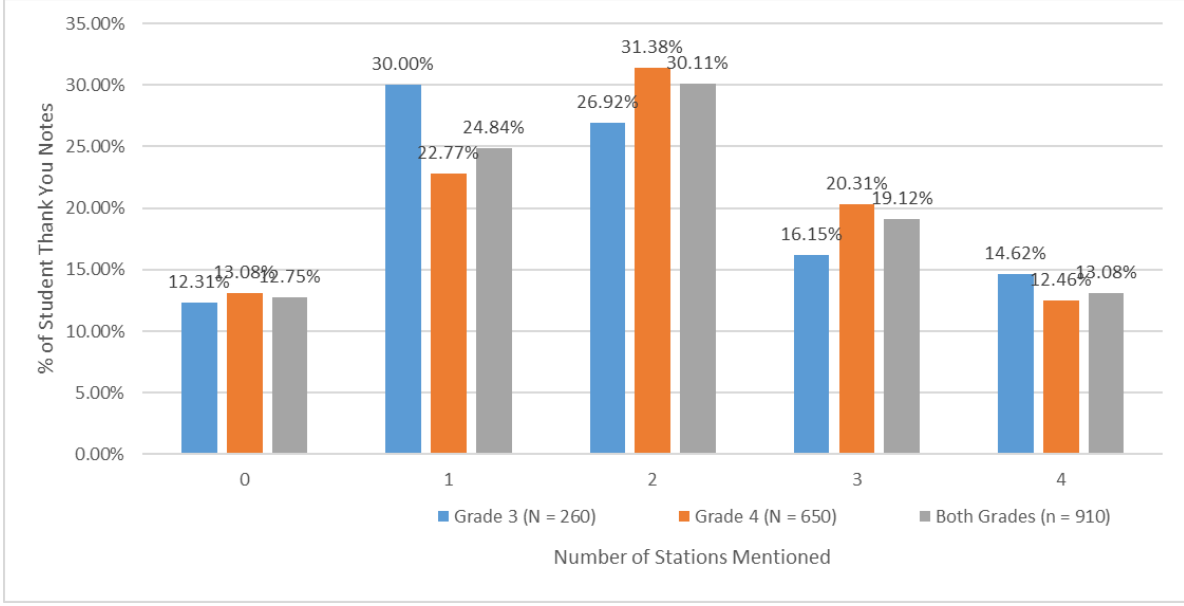
The post survey administered to the teachers showed that 97.8% of teachers stated that the field trip supports their classroom instruction. Teachers rated each station based on their perception of their students’ overall experience. Combined means were cal culated to show the results from these two grades. Each learning station was rated between 4.72 and 4.83 on a 5- point scale, where 1 indicates poor and 5 indicates excellent. Figure 5 summarizes the combined mean teacher rating of student experiences at the field trip